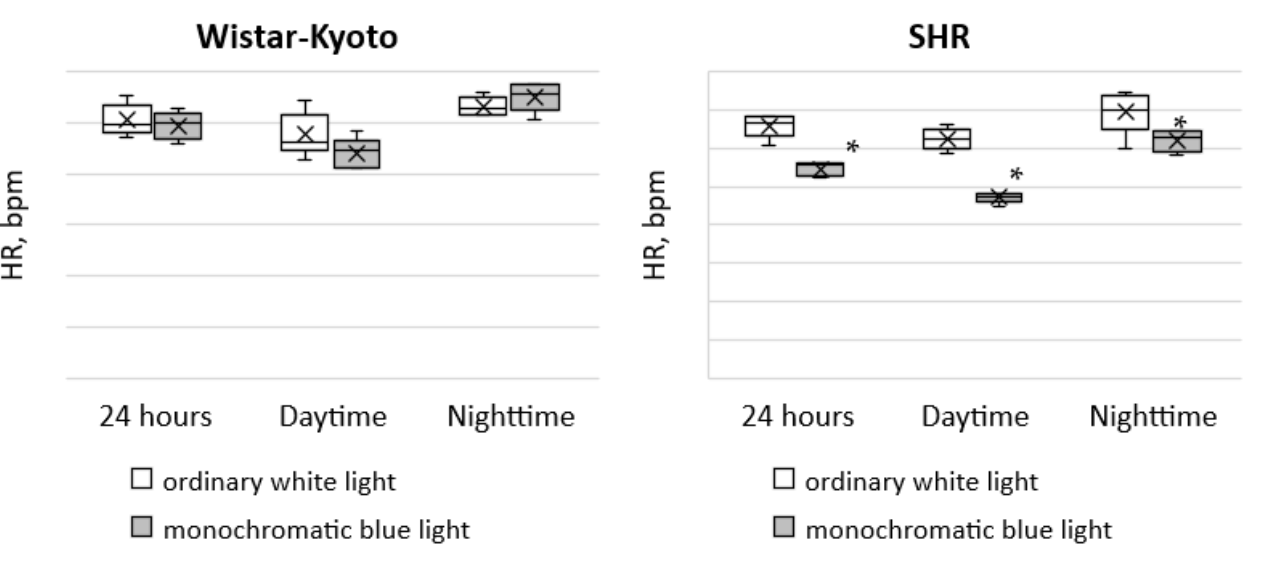
Figure 3. Indicators of the telemetric monitoring of HR in Wistar–Kyoto and SHR rats under the standard light pattern (12 h: 12 h) with ordinary white light and monochromatic blue light. *— p ≤ 0.05.